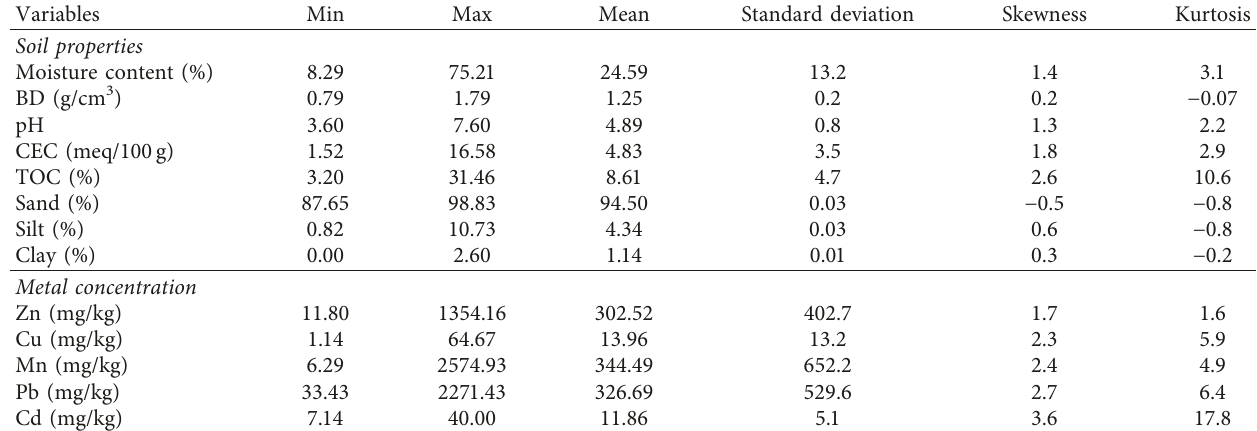
Table 2: Descriptive statistics for soil physical and chemical properties and metal